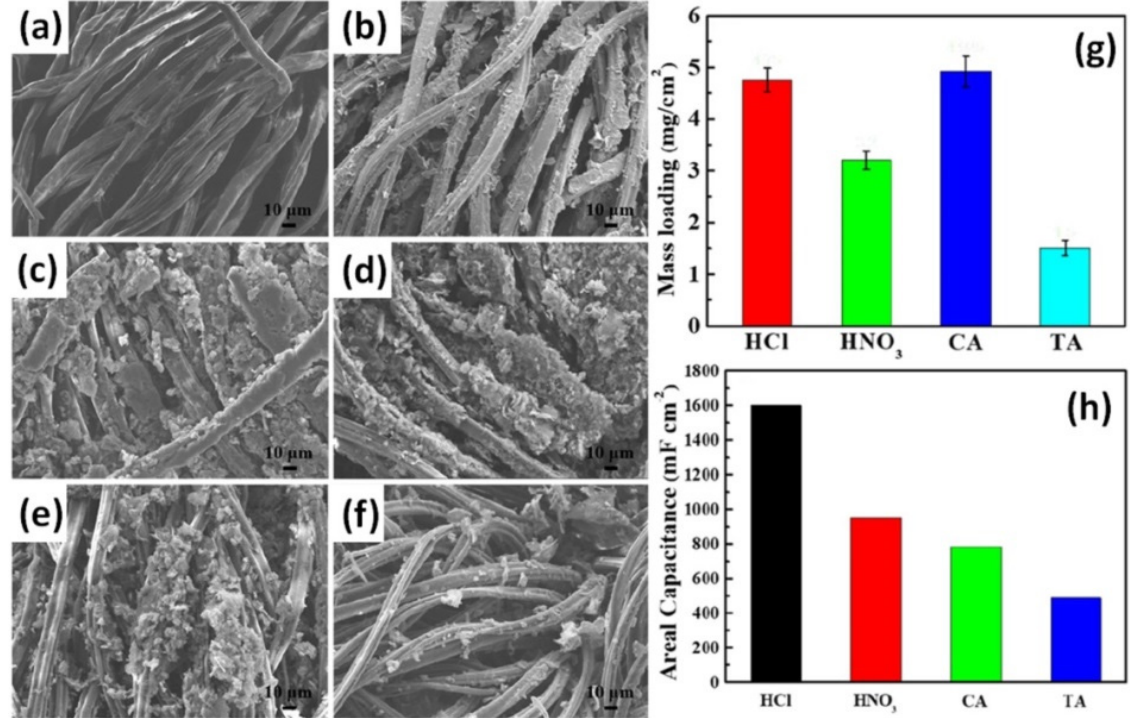
Figure 7. SEM images of the commercially available pristine textile ( a ), graphene on textile ( b ), PANI/G/T-HCl ( c ), PANI/G/T-HNO 3 (d), PANI/G/T-CA ( e ) and PANI/G/T-TA ( f ). Mass loading of PANI with different acid dopants ( g ), the calculated areal specific capacitances four PANI/G/T-based electrodes ( h ) (Reprinted from [94], Copyright 2020, with permission from Elsevier).